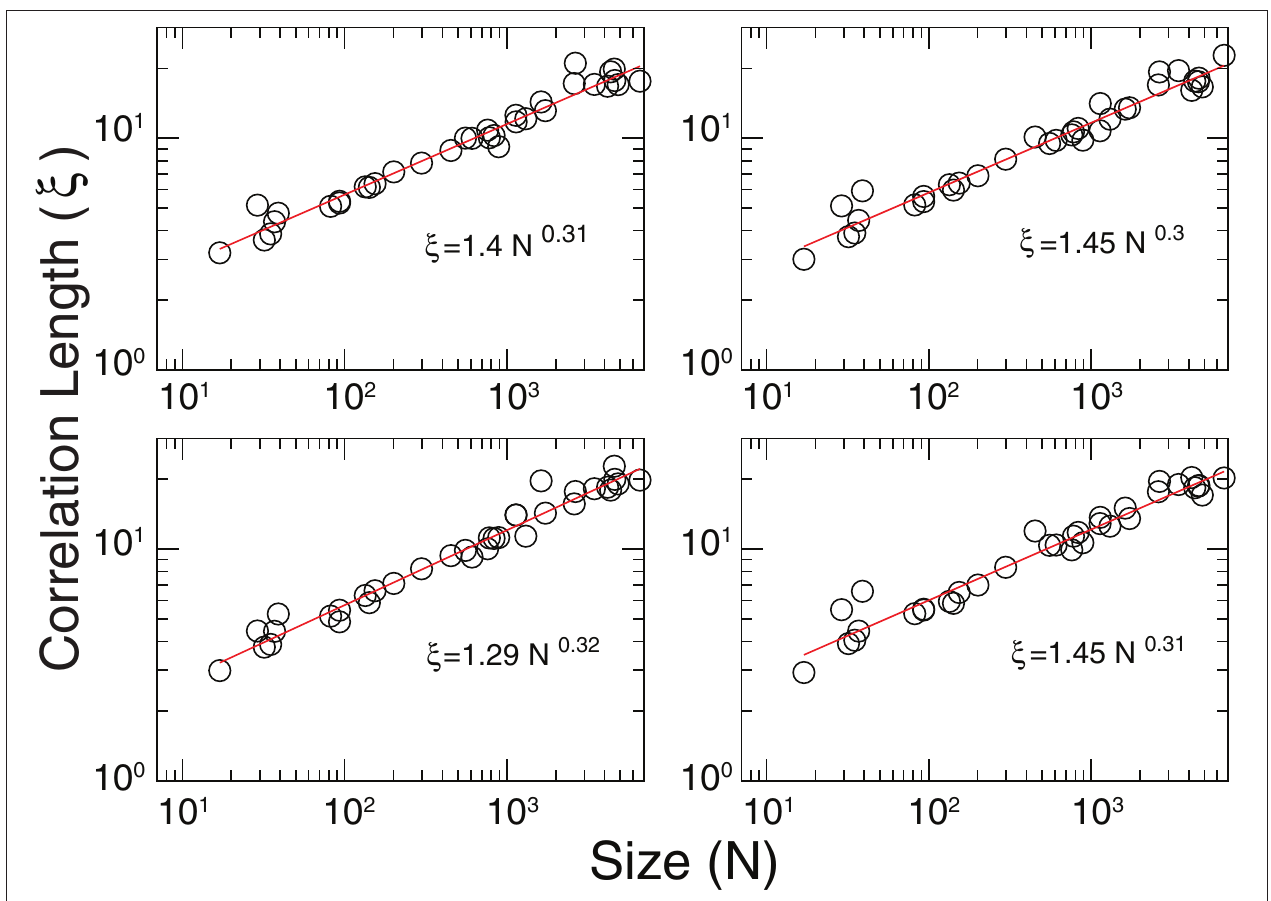
FIGURE A2 | Estimation of the correlation length ξ divergence. In all cases the results are very close to the scaling found in Figure 5 ; ξ ∼ dN 1 / 3 .